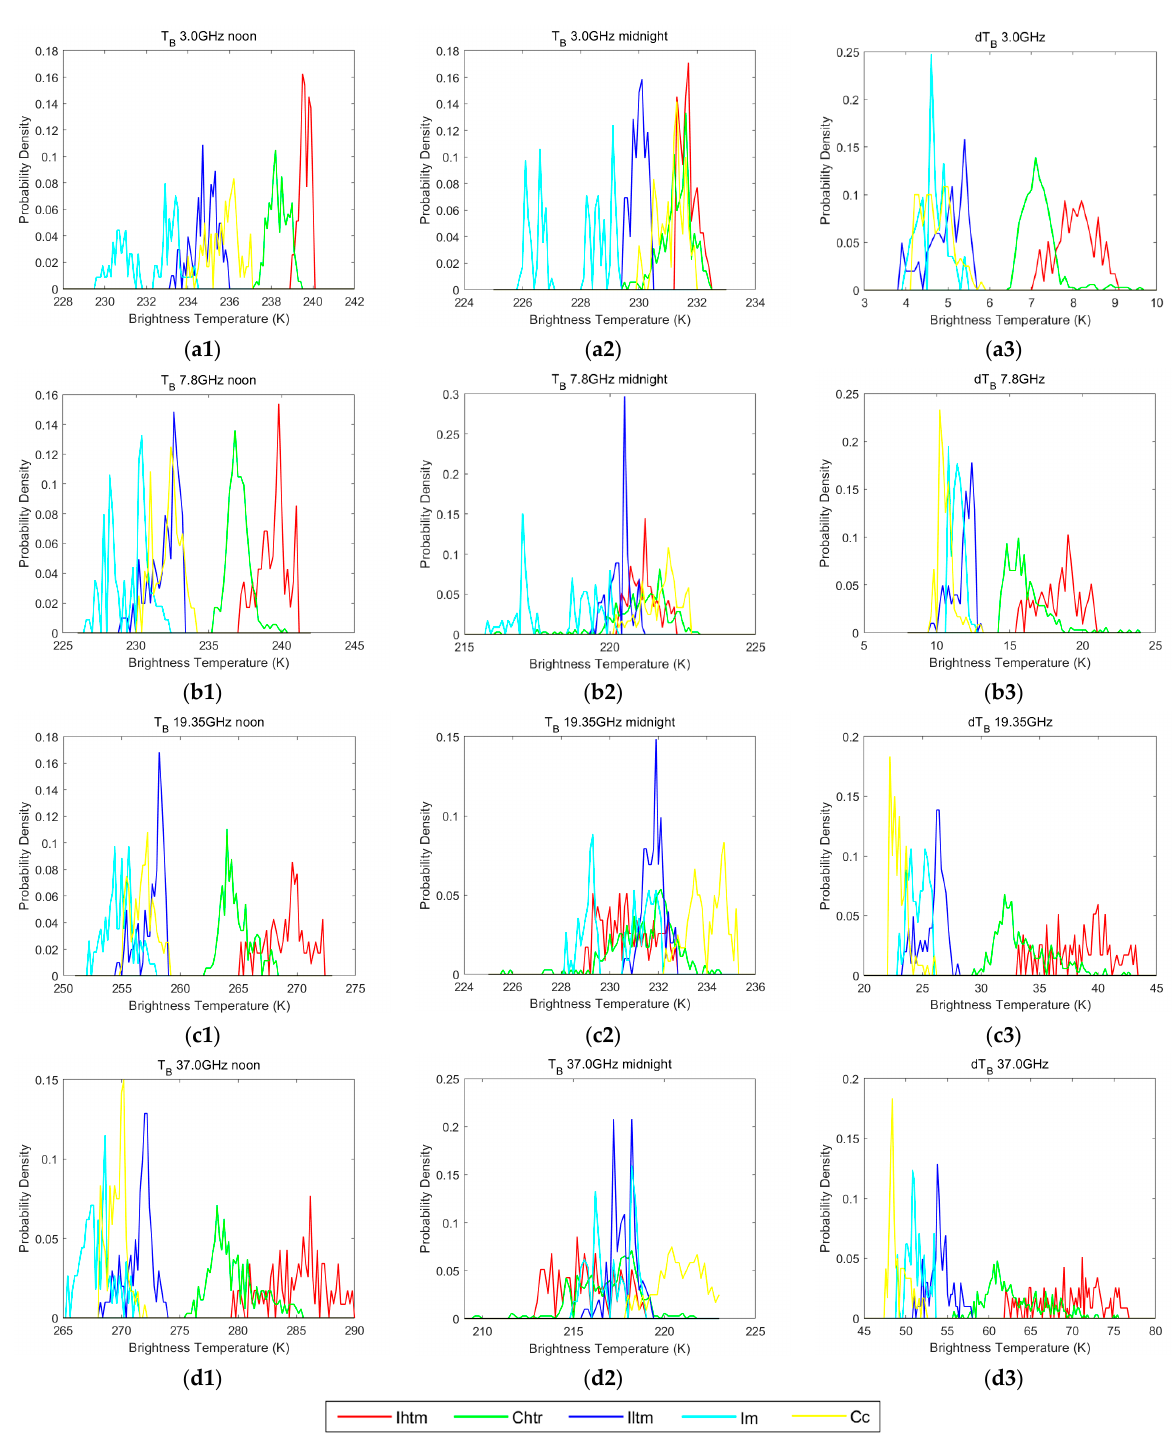
Figure 7. Histograms of T B and dT B features for 5 types of sample units in Mare Fecunditatis. ( a ) 3.0 GHz T B features; ( b ) 7.8 GHz T B features; ( c ) 19.35 GHz T B features; ( d ) 37.0 GHz T B features; ( 1 ) T B noon features; ( 2 ) T B midnight features; ( 3 ) dT B features.